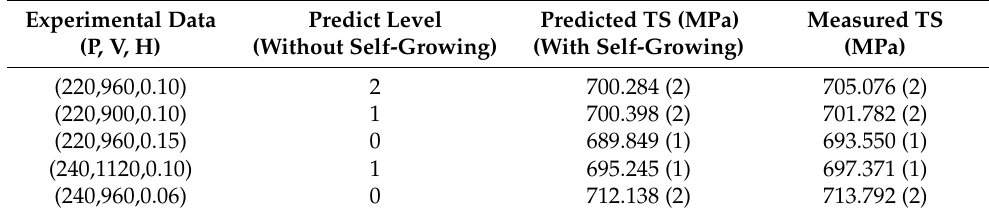
Table 4. The Validation Experimental Setup.